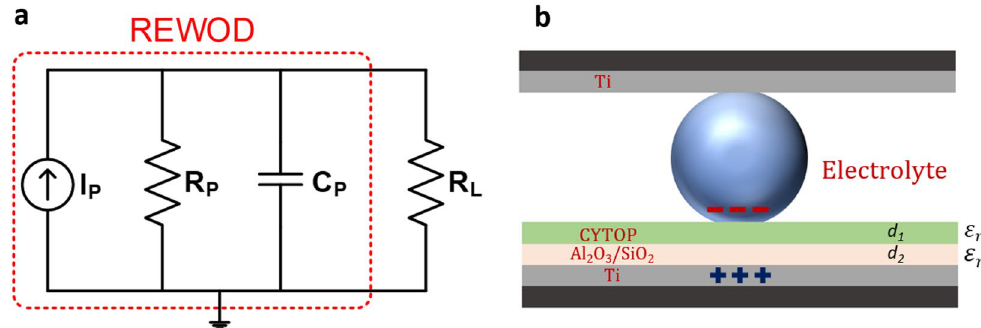
Figure 2. ( a ) Lumped element model of a REWOD energy harvester, ( b ) electrolyte bridge between dielectric and conductive layers showing relevant dielectric constants ( ε r 1 and ε r 2 ) of the dielectric layers and their thicknesses ( d 1 and d 2